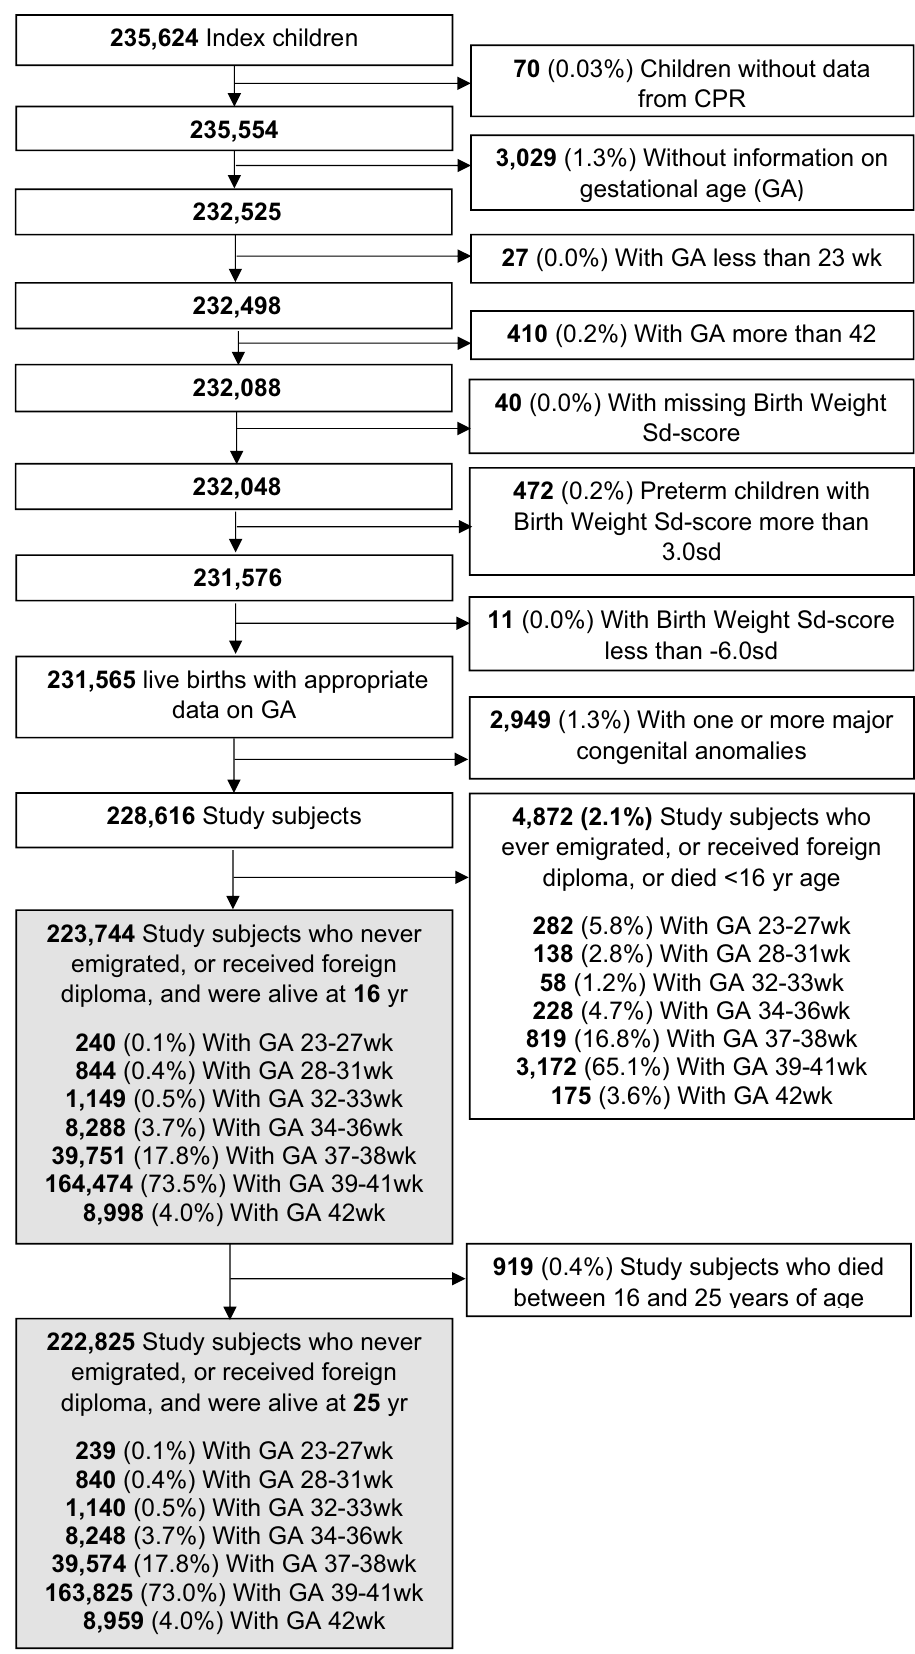
Figure 1. Study population. Note that information on the emigrations and deaths of the individuals were accessible only before 30th April 2012. Birth weight SD-score (BWSDS) was considered inaccurate if it was ≤ − 6.0, or, among preterm index children, > 3.0 according to national sex specific birth weight standards 44 available for the gestational weeks of